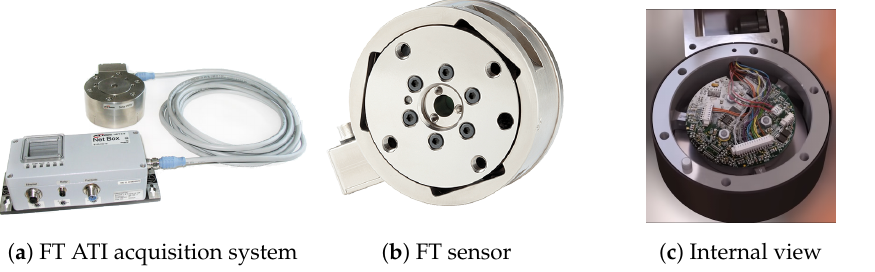
Figure 8. Photos of the force-torque (FT)